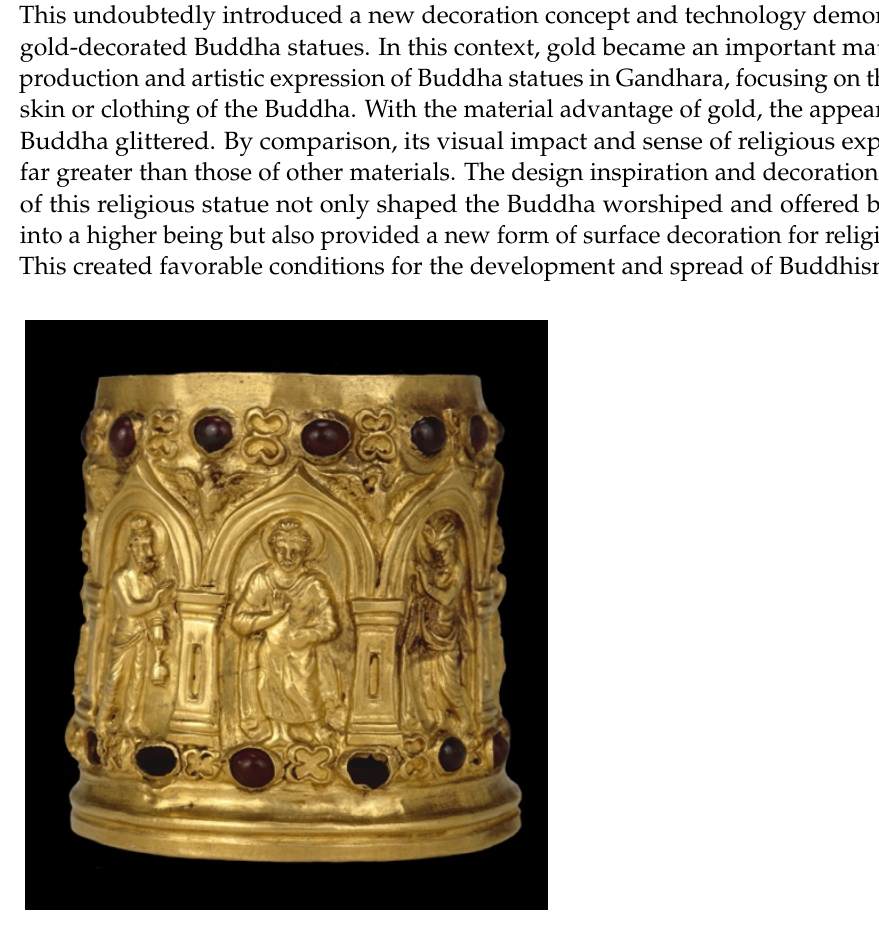
Figure 1. The Bimaran reliquary, 1st century (circa). Materials: gold and garnet. Dimensions: H. 6.5 cm × D. 6.6 cm. Displayed in the British Museum, London, United Kingdom. Photo source: the official website of the British Museum 6 .